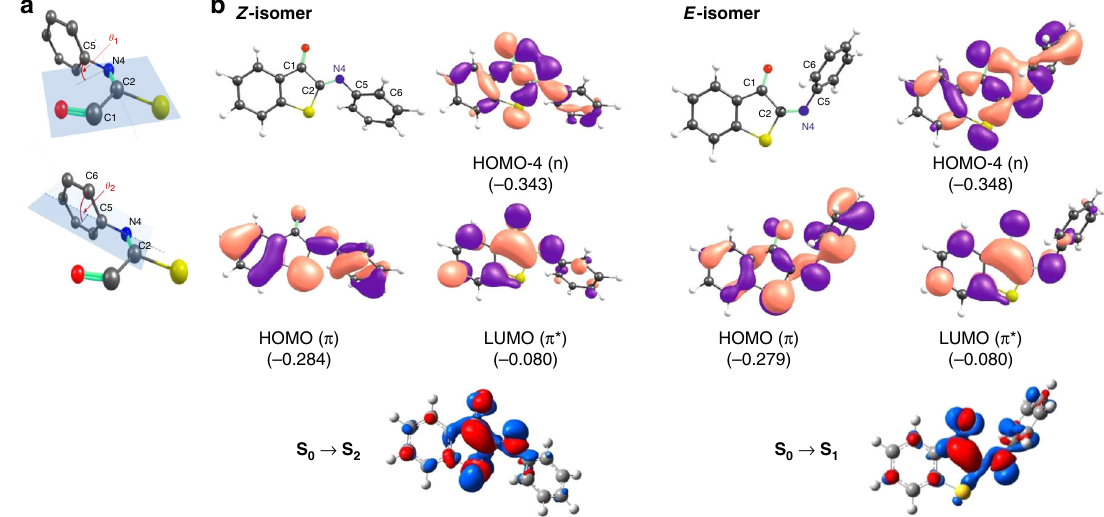
Fig. 2 Computational studies on solvents on ITI photo-isomerization. a Angles θ 1 (top) and θ 2 (bottom). b Structures of the Z and E forms of ITI 1a in MeOH with the numbering of atoms in the central part of a molecule, molecular orbitals involved in the observed electronic transition (energies in Hartrees) and electron density difference (EDD) plots showing the decrease (blue) and increase (red) of the electron density upon excitation obtained at the SMD-TD- M06-2X/6-311 ++ G(2df,2p)//SMD-M06-2X/6-31 + G(d) level of